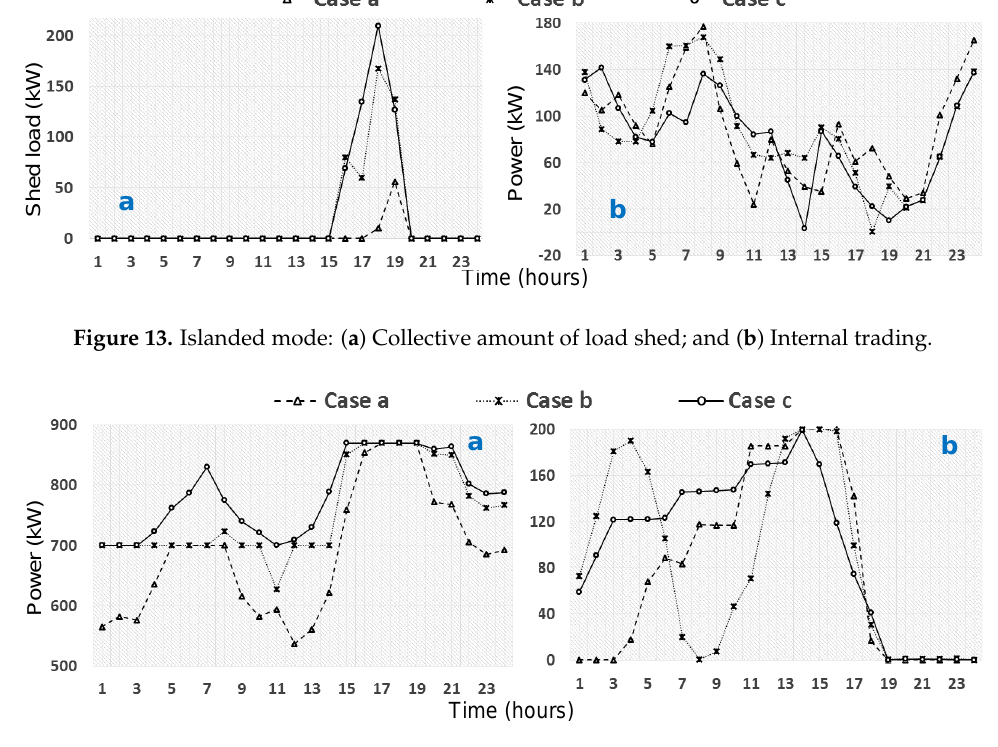
Figure 14. Islanded mode: ( a ) Collective generation amount of CGs; and ( b ) Cumulative SOC of BESSs.